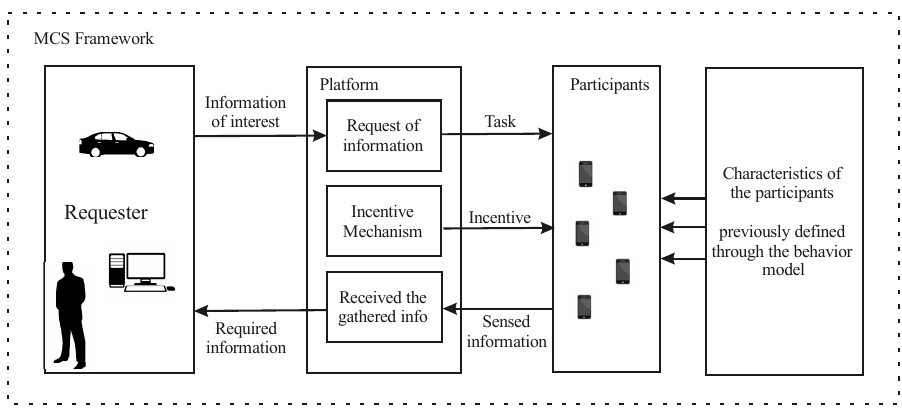
Figure 1. Proposed Framework for MCS.